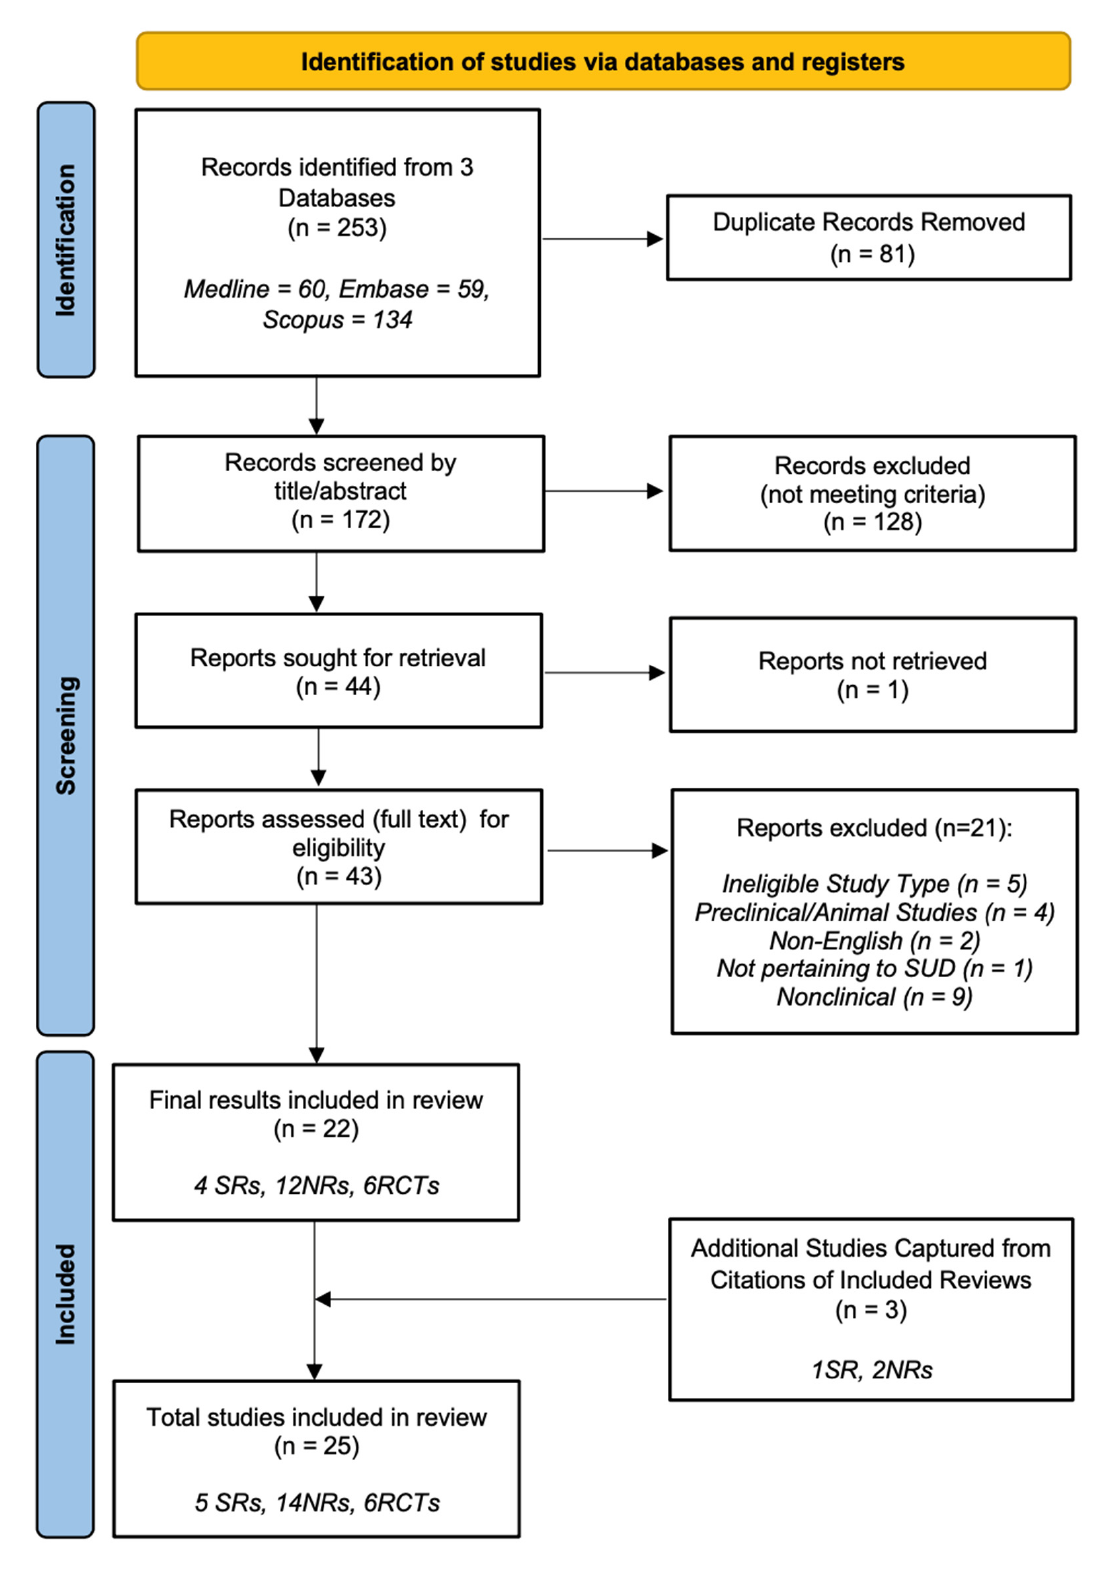
Figure 1. PRISMA flow chart of narrative review search methods.